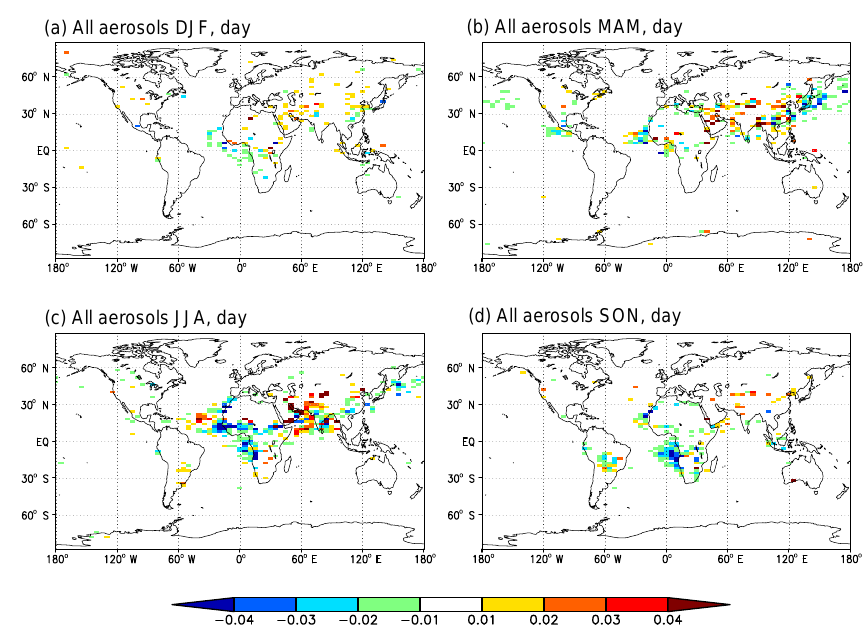
Figure 2. Daytime difference between AOD above the maximum low-cloud-top height over low clouds and the AOD above the same height in the clear-sky neighborhoods for (a) DJF, (b) MAM, (c) JJA, and (d) SON. Positive values mean that the aerosols above low clouds have a larger AOD than that in the clear-sky portion of the grid